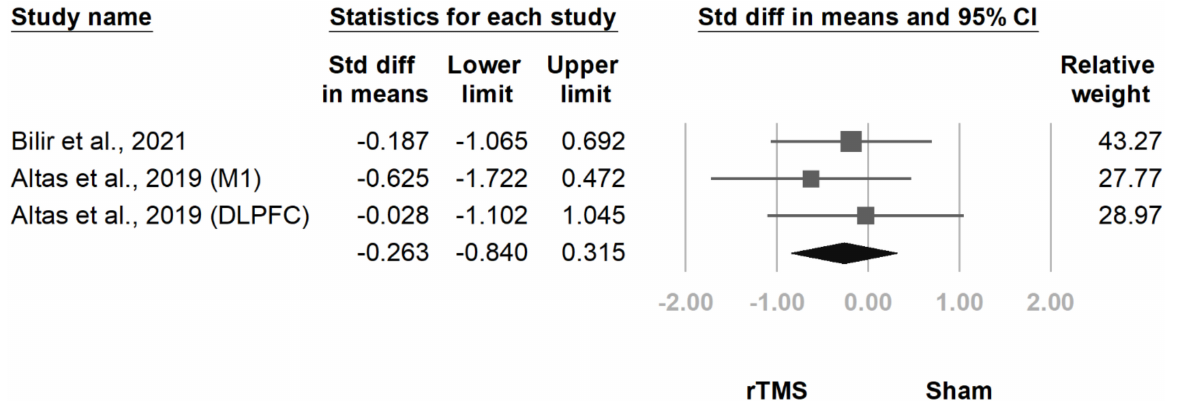
Figure 21. Forest plot of standardized mean differences in Fatigue Severity Scale after treatment. Squares indicate effect sizes of individual studies, lines indicate 95% CI, and diamond indicates the summarized effect